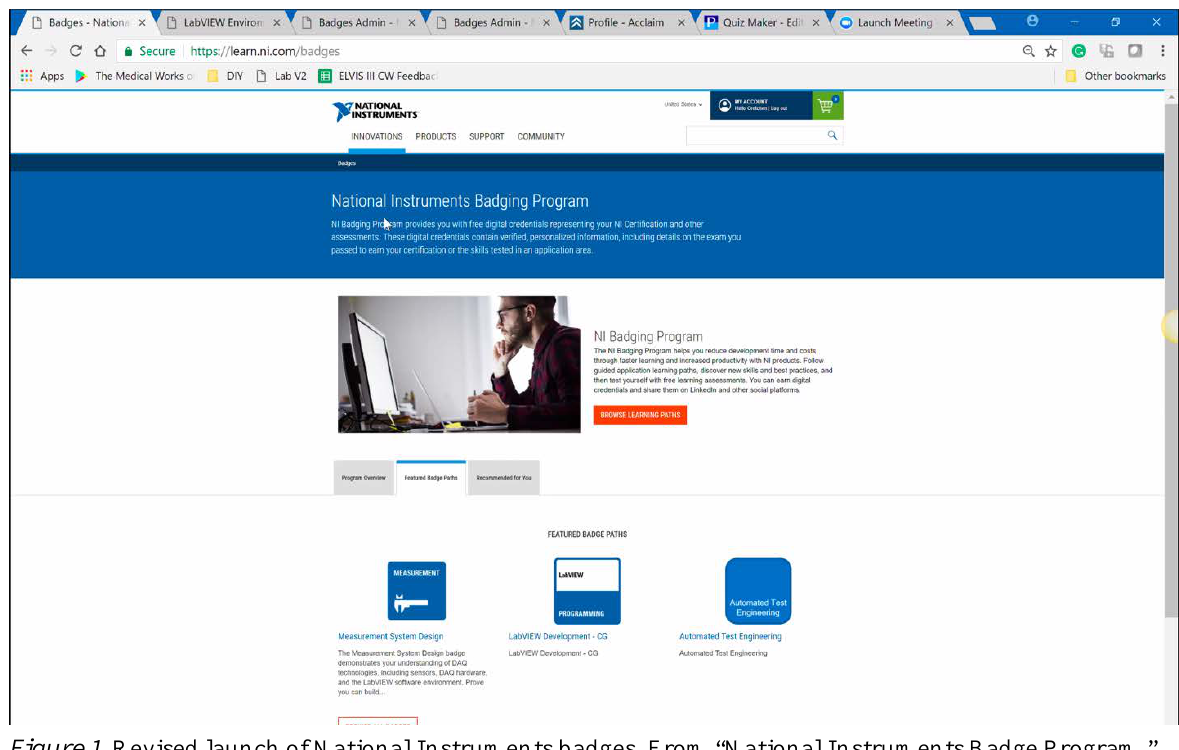
Figure 1. Revised launch of National Instruments badges. From “National Instruments Badge Program,” by National Instruments, 2019b (https://learn.ni.com/badges). In the public domain. A key feature of National Instruments’ expanded badging project is learning paths. Touted on the main page (see Figure 2), these pathways help guide learners towards collecting badges that aggregate to automatically issue larger credentials. Earners’ progress on these pathways is represented by the colored bar to the side of the badge (see Figure